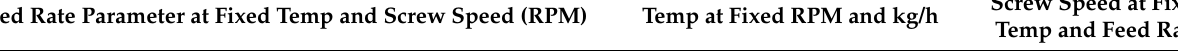
Table 7. Optimum processing values for color output. Optimum Processing Values for the Three Grades Temp at Fixed RPM and